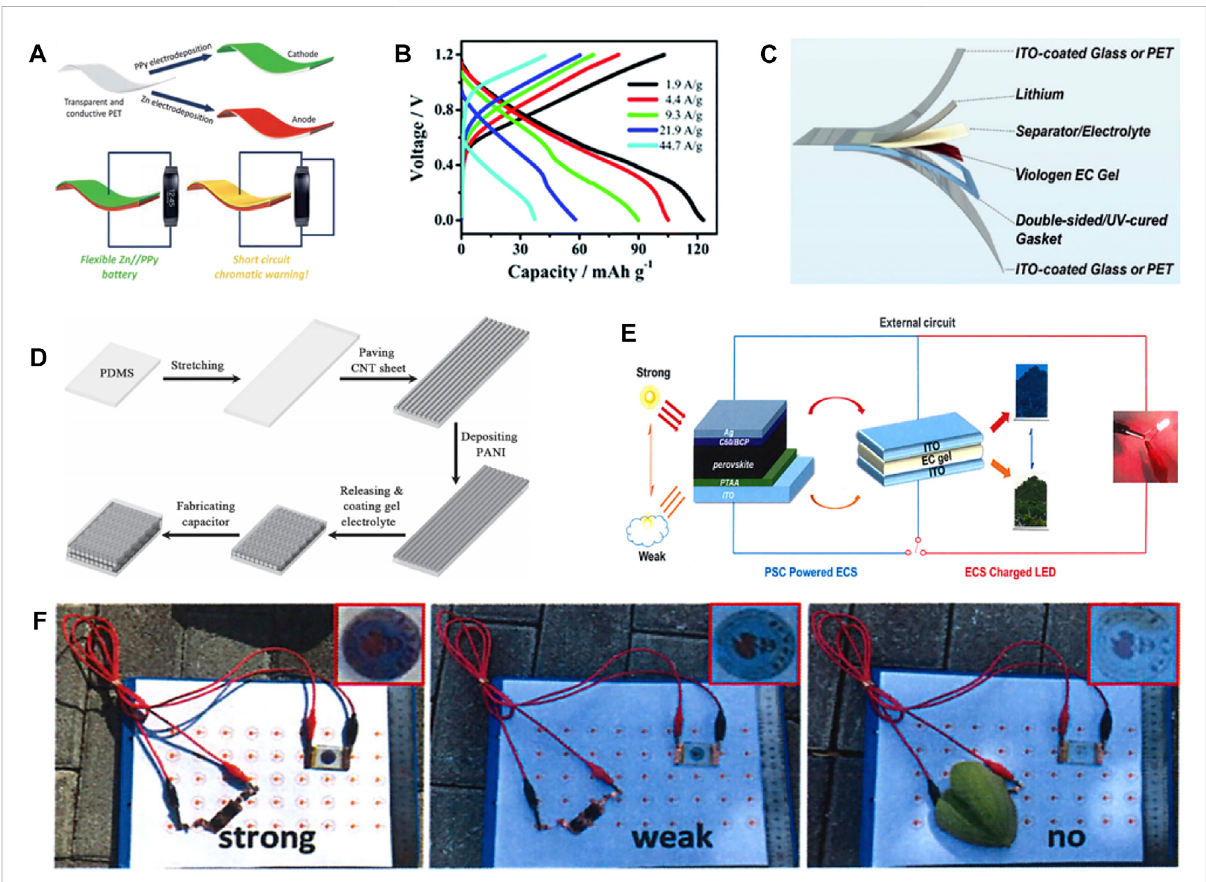
FIGURE 2 (A) Schematic diagram of Zn//PPy battery with short-circuit warning function. (B) GCD curves of Zn//PPy battery at different current densities. (Wang et al., 2018) with permission from Royal Society of Chemistry. (C) Flexible ECLIB based on Poly (chalcogenoviologen). (Li G. et al., 2019) with permission from Wiley-VCH. (D) Schematic diagram of thefabricationof stretchable ECSCs. (Chen etal., 2014)with permission from Wiley-VCH. (E) Schematic diagram of the electrochromic device driven by PSC. (F) The photos of PSC-powered electrochromic device under different light intensities. (Ling et al., 2021) with permission from